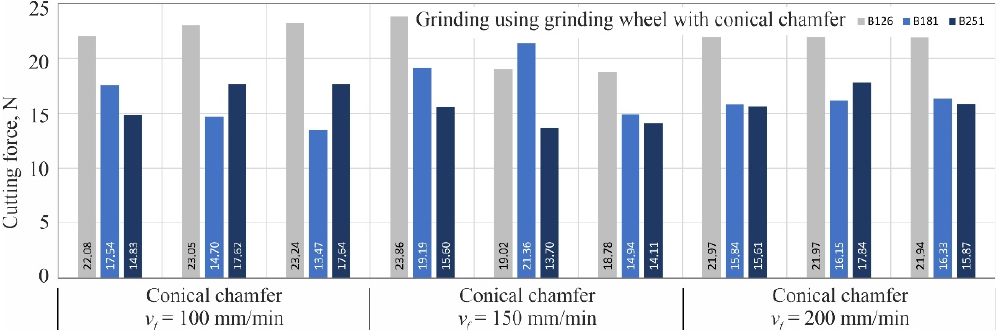
Figure 7. Results of cutting force measurements with blades shaped by grinding wheel with conical chamfer made of cBN abrasive grains B126, B181 and B251 at feed rates v f of 100; 150; 200 mm/min. To simplify the analysis of the obtained results of cutting force measurements, a chart was also drawn up showing its average values determined from measurements of three blades shaped with the same grinding process parameters (Figure 8).